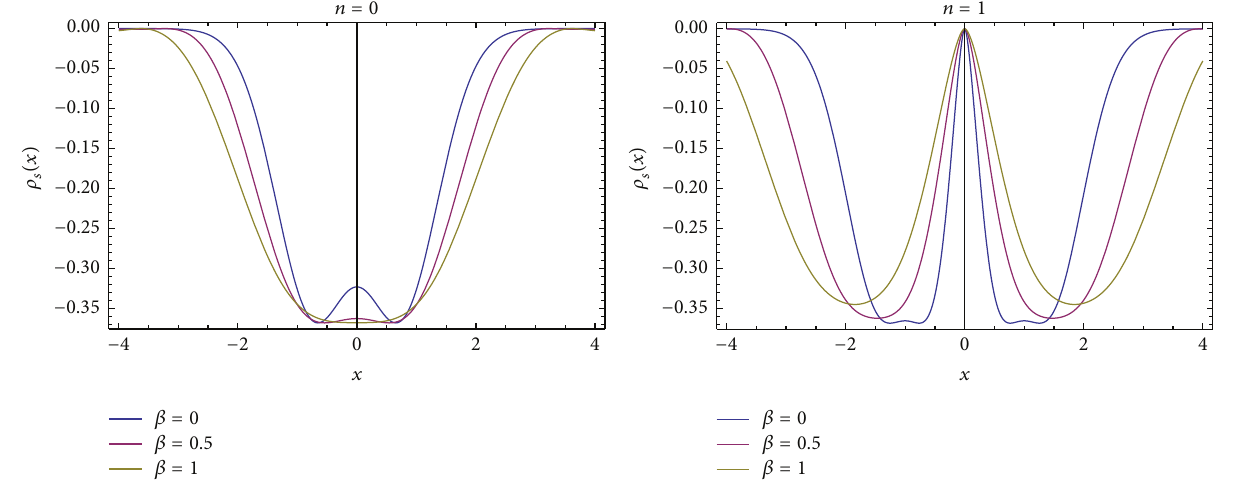
Figure 3: Plots of the position space entropy densities for 𝑚 = ℏ = 𝜔 = 1 and 𝑛 = 0, 1 .